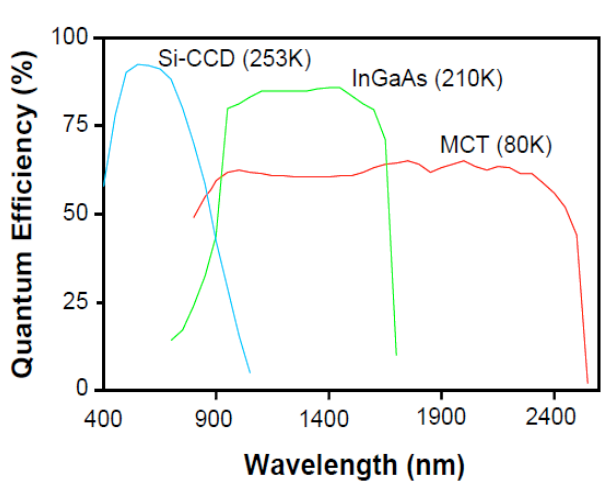
Fig. 1. Quantum efficiency of typical Si-CCD, MCT and InGaAs focal plane arrays